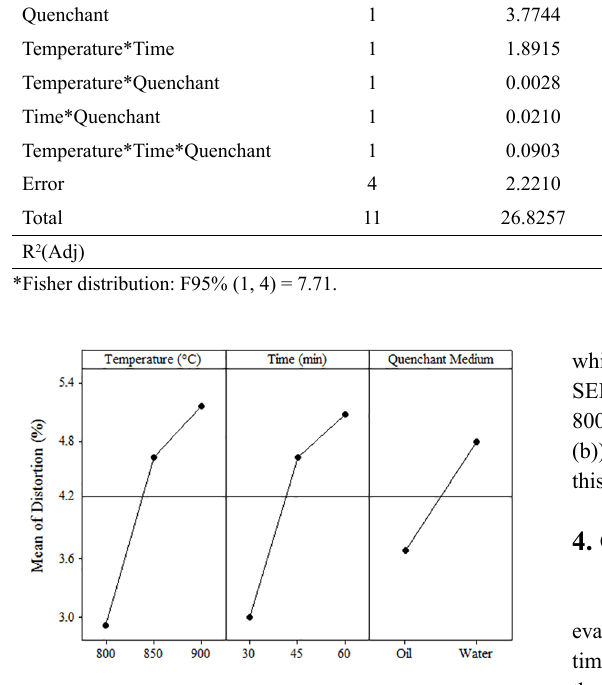
Figure 6. Main effects plot (data means) for Distortion (%).